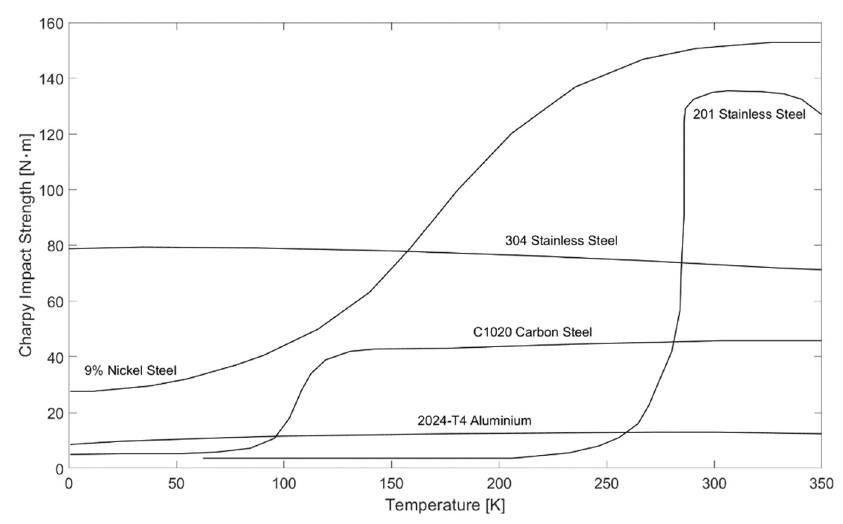
Figure 4. Charpy impact strength as a function of temperature for various materials based on